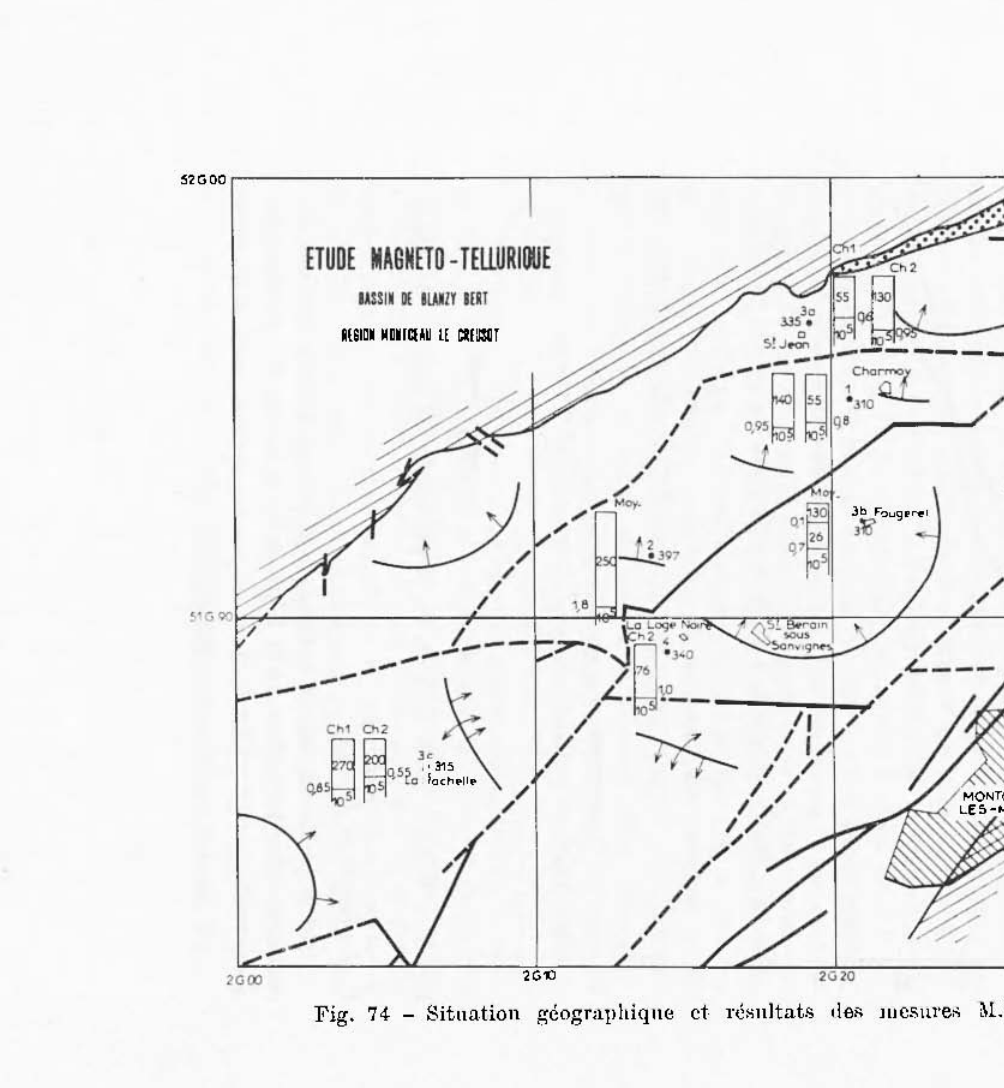
Fig. 74- _ Sitllation géographiqne ct l"éHnltats de;; llJCSlll'e~ ~LT. dans le 13assin de Bln.nzy